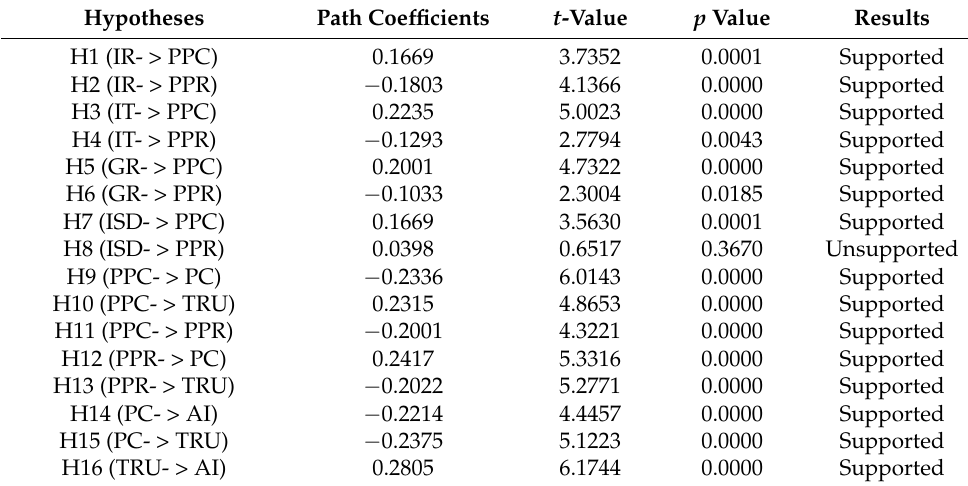
Table 6. Summary of hypotheses testing